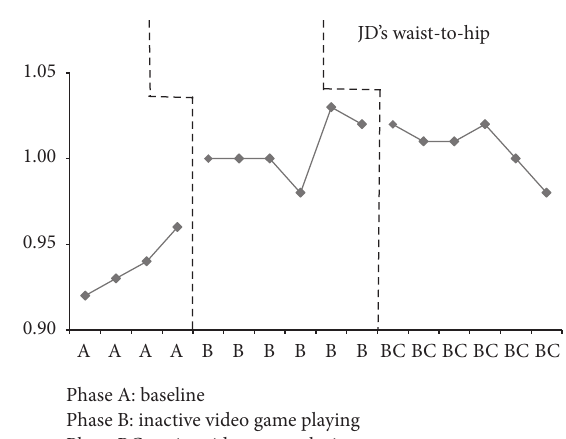
Figure 4: JD’s waist-to-hip ratio across all phases.